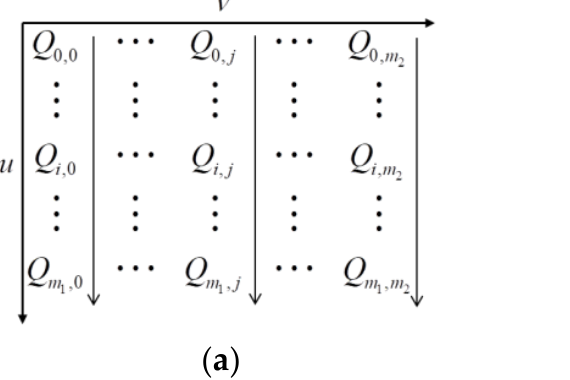
Figure 1. ( a ) u -direction and the v -direction, ( b ) row parameter